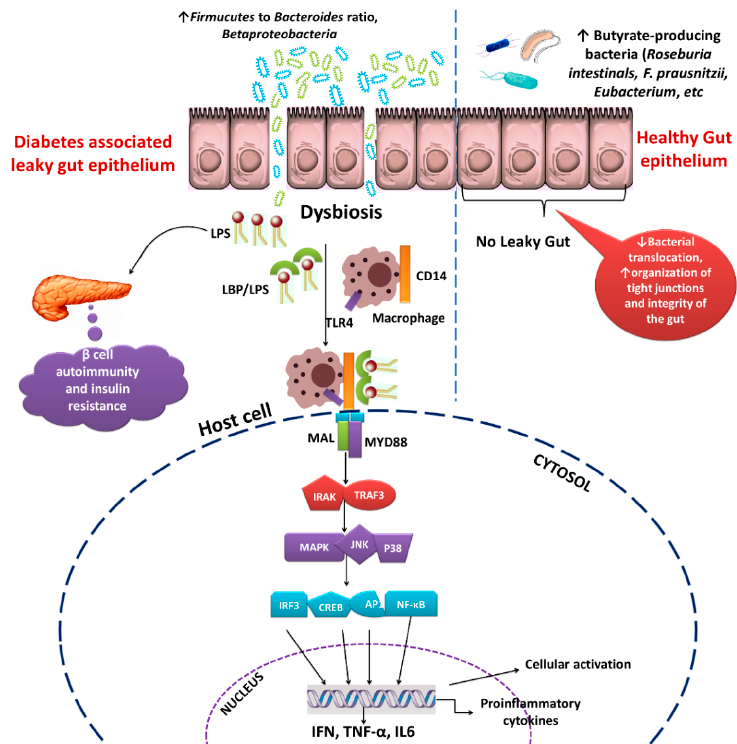
Figure 4. Altered microbial communities enhance the gut permeability and cause leaky gut. The lipopolysaccharide binding protein (LBP), synthesized from the liver, acts as a carrier of LPS. LPS is the primary constituents of the outer membrane of intestinal bacteria, known to cause chronic inflammation in the host. LPS/LPB complex assembles with membrane-bound CD14 (cluster of differentiation 14) molecules and toll-like receptor 4 (TLR4) on the surface of macrophages in the host. TLR4signaling is initiated by ligand-induced dimerization of receptors, which engage with adaptor proteins like MYD88 (myeloid differentiation primary response protein 88) and MAL (MYD88-adaptor-like protein). These downstream signaling pathways stimulate the connections